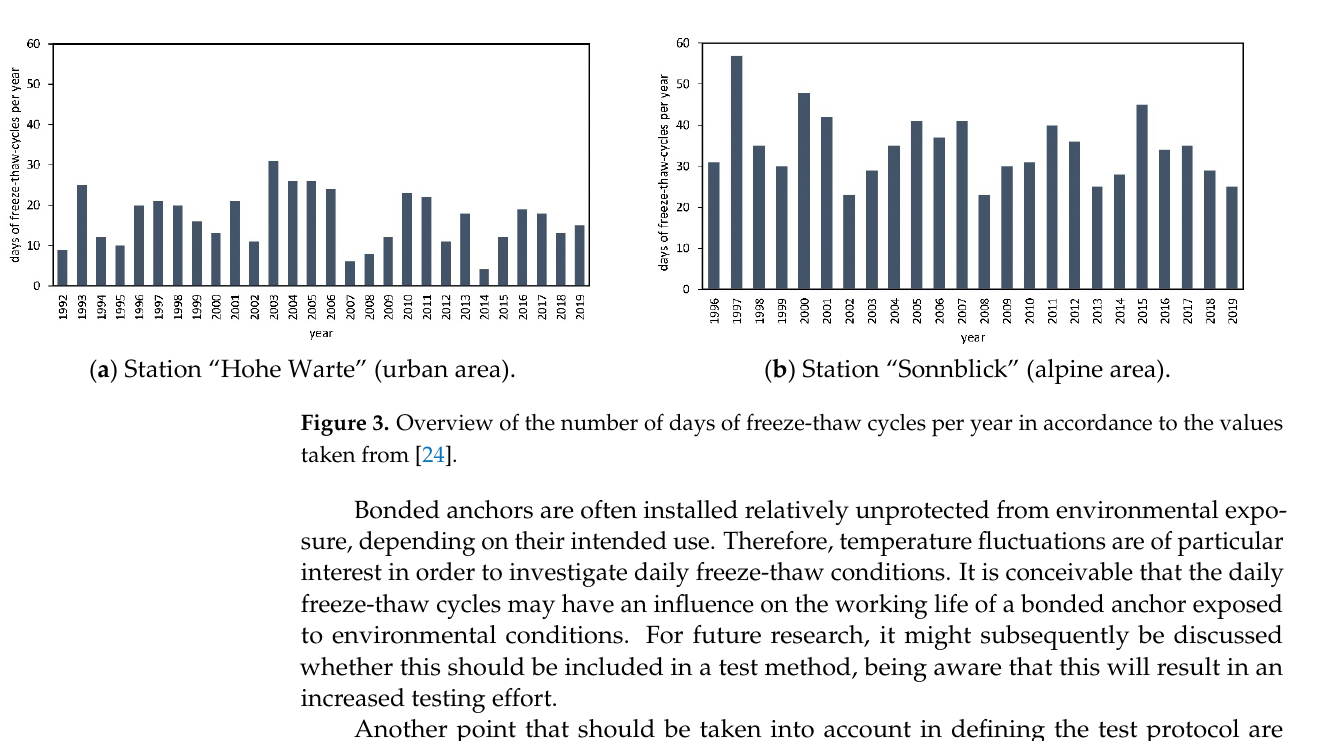
Figure 3. Overview of the number of days of freeze-thaw cycles per year in accordance to the values taken from [24].